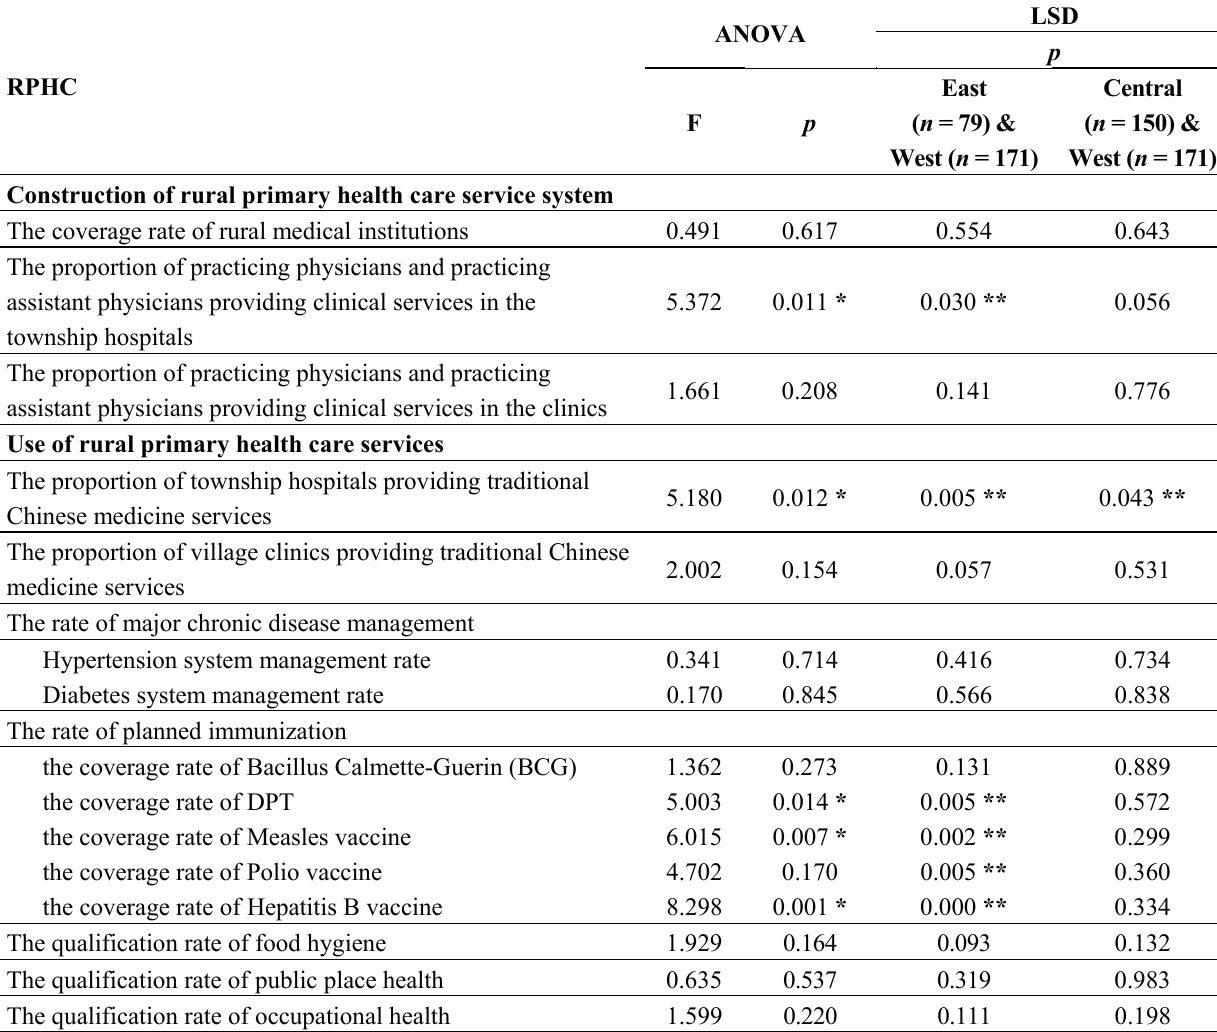
Table 4. Differences in RPHC among Western, Central and Eastern China based on ANOVA and